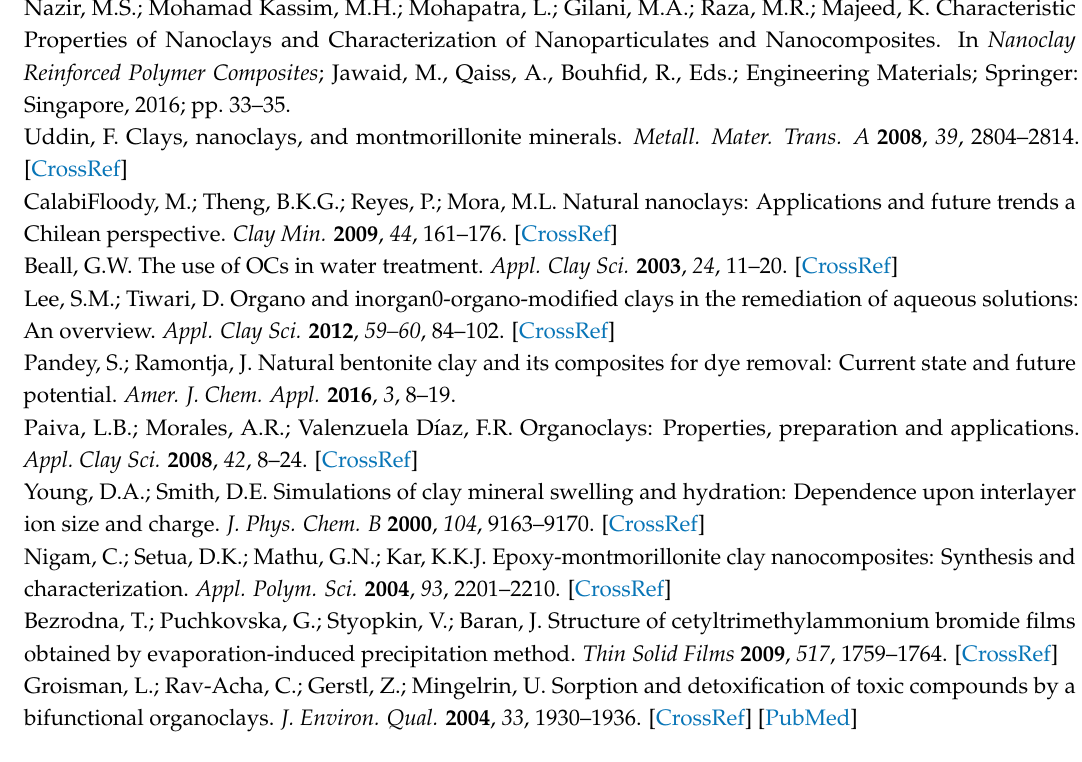
Figure S5: Evolution of removed amount (mg/g) and removal percentage (%) using C16BrPG-2.40 organo-clay, Figure S6: Eosin removal properties of C16BrPG-2.40 organo-clay performed at different temperatures, Figure S7: The Van’t Hoff plot of eosin removal by C16BrPG-2.40 organo-clay at different temperatures, Figure S8: Removal capacity of C16OHPG-2.40 preheated at different temperatures and using two C i values 200 mg/L (black) and 1000 mg/L